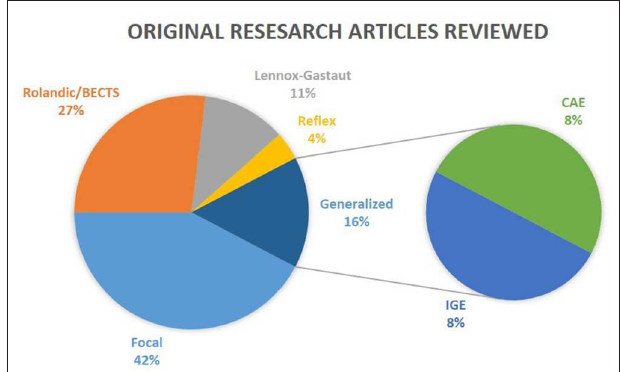
FIGURE 1 | Epilepsy types reviewed. The results of the review on clinical studies are separated into five distinct categories: Rolandic/BECTS, Lennox-Gastaut, Reflex, Focal, and Generalized. CAE and IGE patients are considered subgroups of Generalized epilepsy. Reviews were not taken into consideration in this